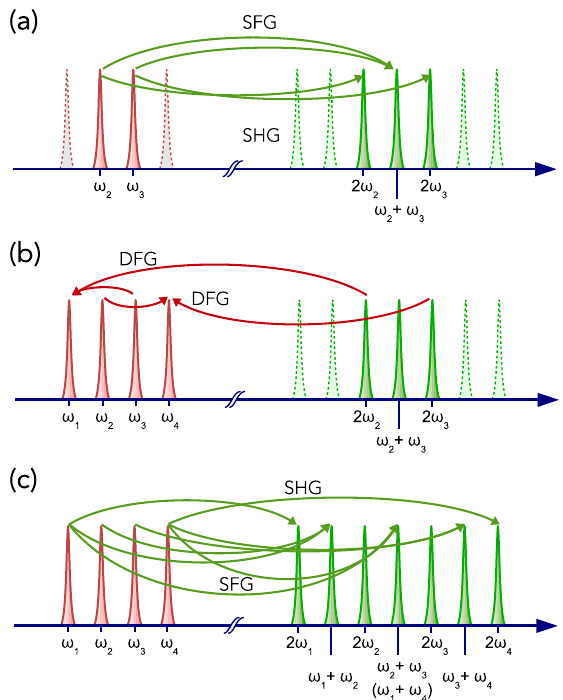
Figure 9: Schematic representation of cascaded quadratic pro- cesses mimicking nondegenerate FWM in the case of a bichromat- ically pumped cavity: (a) the initial presence of two input subhar- monic modes, ω 2 and ω 3 , enables the generation of three harmonic fields by SHG and SFG; (b) DFGs between the second harmonics and the original subharmonic fields result in two new symmetrically placed output sub-harmonic fields, ω 1 and ω 4 , which successively (c) generate other harmonic fields. From the point of view of the subharmonic fields, the process is equivalent to a χ (3) non degener- ate